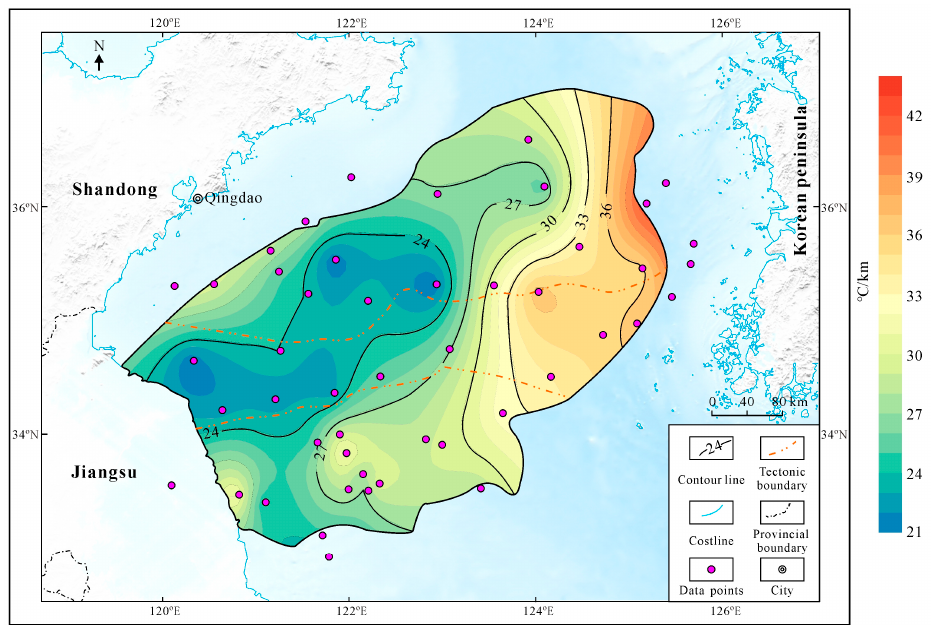
Figure 4. Geothermal gradient map of Cenozoic strata in the South Yellow Sea Basin (geothermal gradient data from the International Heat Flow Commission [66]).